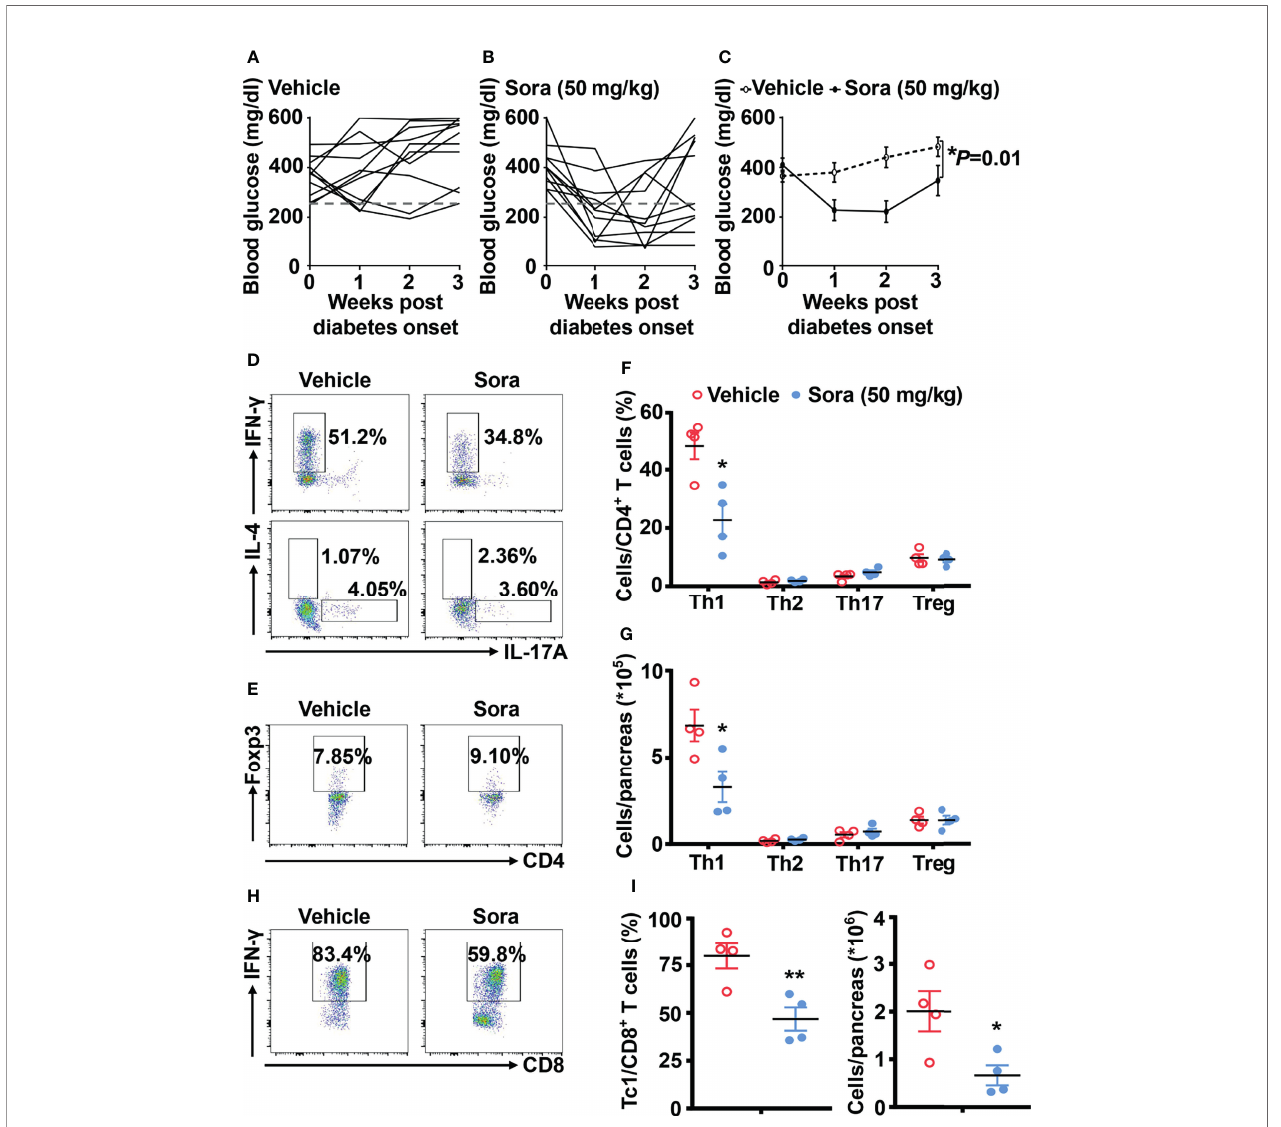
FIGURE 4 | Sorafenib reverses autoimmune diabetes in NOD mice. The trend of blood glucose (A – C) from vehicle-treated (n = 11) and sorafenib-treated (50 mg/kg, n = 10) new-onset diabetic NOD mice (diagnosed by two consecutive readings of blood glucose>250 mg/dl). Flow cytometry analysis of the frequency and number (D – G) of Th1, Th2, Th17 cells and Tregs in pancreas from vehicle-treated or sorafenib-treated diabetic NOD mice. Flow cytometry analysis of the frequency and number (H, I) of Tc1 cells in pancreas from vehicle-treated or sorafenib-treated diabetic NOD mice. Sora, sorafenib. Data represent means ± s.e.m. N = 4 mice per group in each experiment. Statistical signi fi cance: * P < 0.05, ** P < 0.01 versus vehicle by